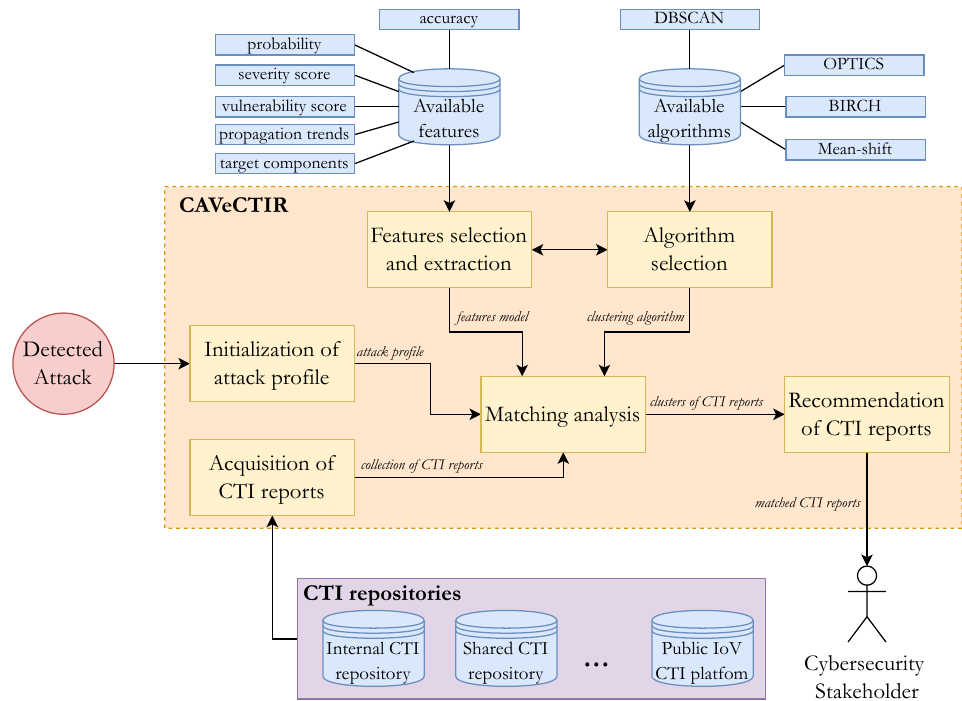
Figure 1. The conceptual structural diagram of